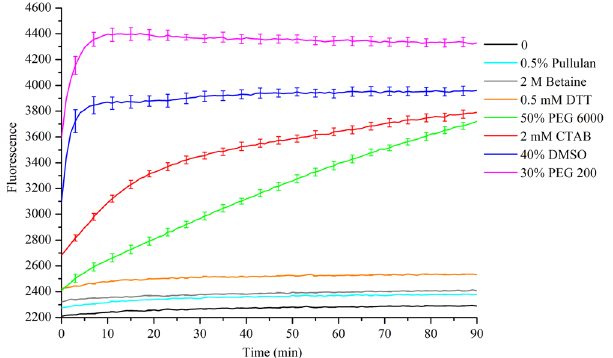
Figure 2. The comparison of the effects of several substances on DNA strand exchange by real-time fluorescence.